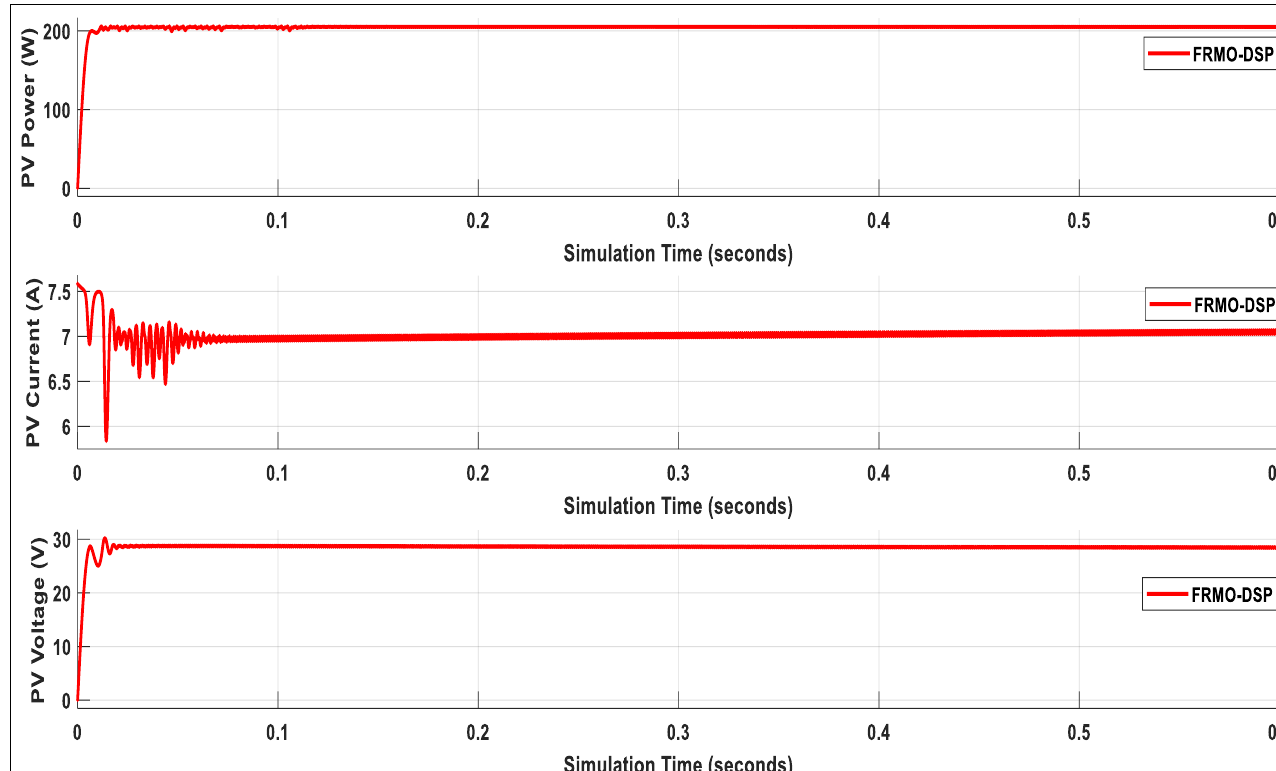
Figure 20. PSC pattern 3 FRMO-DSP MPPT results (case study 3).